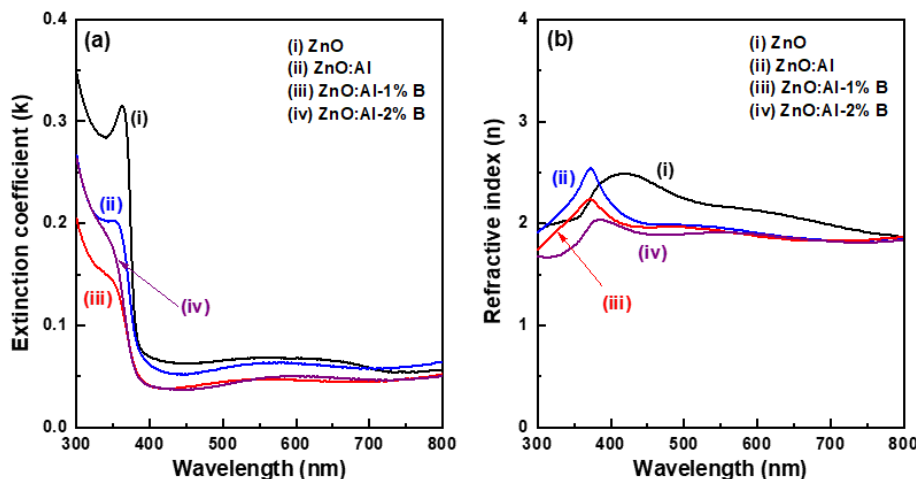
Figure 7. ( a ) Extinction coefficient (k) and ( b ) refractive index (n) varied with wavelength in the ZnO, ZnO:Al and ZnO:Al-B thin film samples.